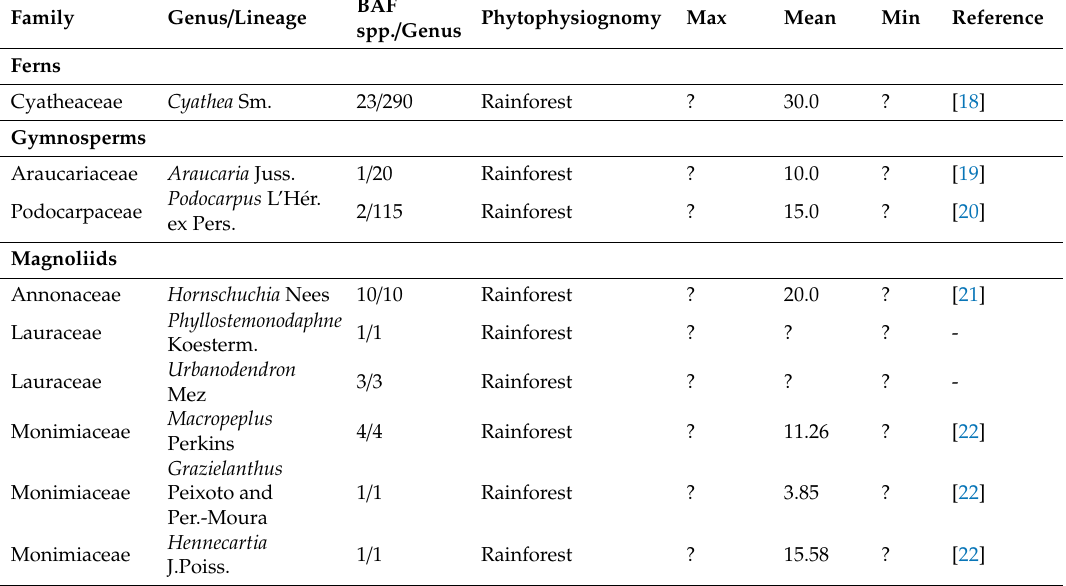
Table 2. Age of Brazilian Atlantic Rainforests (BAF) lineages of vascular plants based on phylogenetic literature and distribution data from Flora do Brasil [13] and Plants of the World Online [17]. ? refers to ages unavailable from the consulted